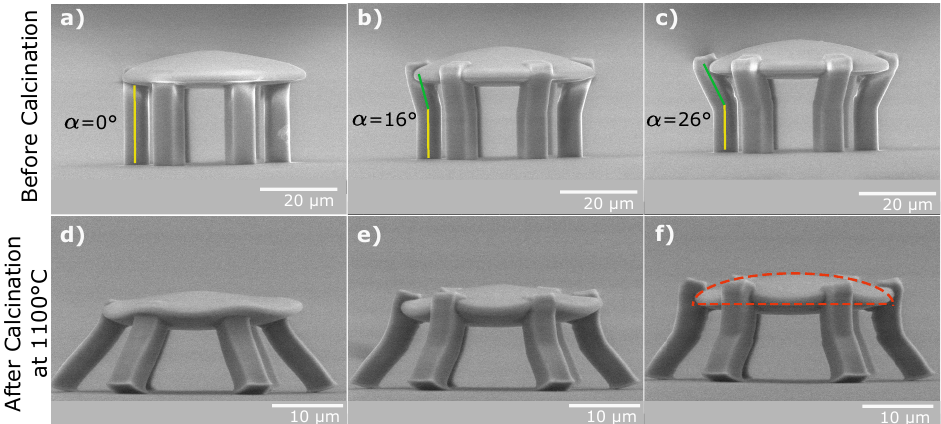
Figure 3. Shrinkage and shape pre-compensation of calcinated micro-optics. The first row shows the initial shape of micro-lenses of 50 µ m diameter prior calcination with support angles of ( a ) 0 ◦ , ( b ) 16 ◦ and ( c ) 26 ◦ . The bottom row ( d – f ) shows the same microstructures after calcination at 1100 ◦ C. In ( f ), the arrows indicate the preserved shape of the lens despite the overall structure, mainly the legs, being partially distorted. However, the central part of the volume is still lens-like and thus performs as a micro-optical component (demonstrated in Figure 4).